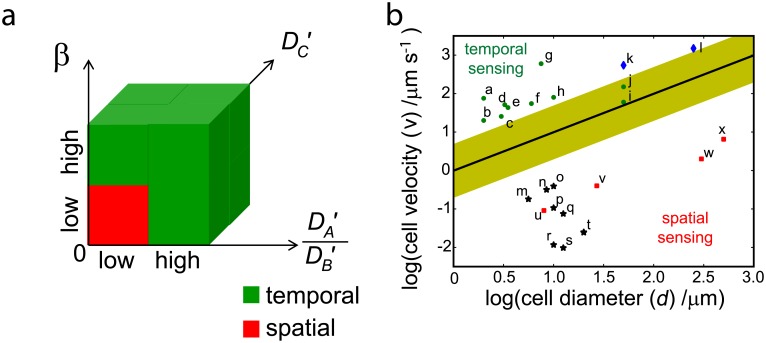
Choice of temporal versus spatial sensing.(a) Parameter space for choice of temporal versus spatial sensing. (b) Plot of log(cell diameter, d) versus log(cell velocity, v) for chemotactic cells. The respective cells are as follows; In the flagellar group (green dots) are a: Vibriocholarae, b: Escherichia
coli, c: Helicobacter
pylori, d: Pseudomonas
aeruginosa, e: Salmonella
typhimurium, f: Marine Vibrioid bacteria sampled from Niva Bay, g: Thiovulum
majus, h: Chlamydomonas
reinhardtii, i: Sperm (human) and j: Sperm (Sea urchin). In the cilia group (blue diamonds) are k: Tetrahymena
thermophila and l: Paramecium. In the lamellipodia/filopodia group (black stars) are m: T cell, n: Neutrophil, o: Hemocyte, p: B cell, q: Dendritic cell, r: Endothelial cell, s: Fibroblast and t: Border cells. In the pseudpodia group (red squares) are u: Dictyostelium
discoideum, v: Acanthamoeba
castellanii, w: Amoeba
proteus and x: Chaos
carolinensis. Assuming a signaling rate, lBC, occurring between 0.2s−1 to 5s−1 then the yellow region will be the separating boundary between cells with high and low values of β. The black line is the decision boundary for lBC = 1s−1.